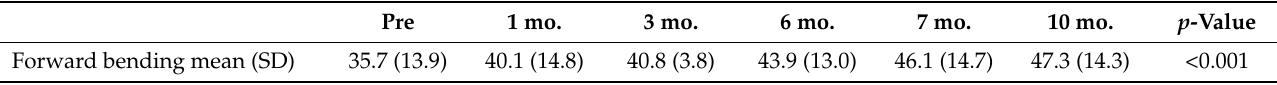
Table 5. Change in flexibility.